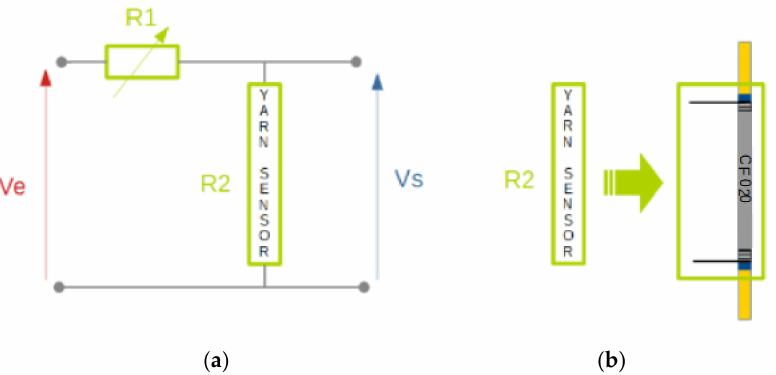
Figure 4. Diagram of the voltage divider ( a ) and the correspondence between the electrical resistance R2 and the sensor zone of the sensor yarn ( b